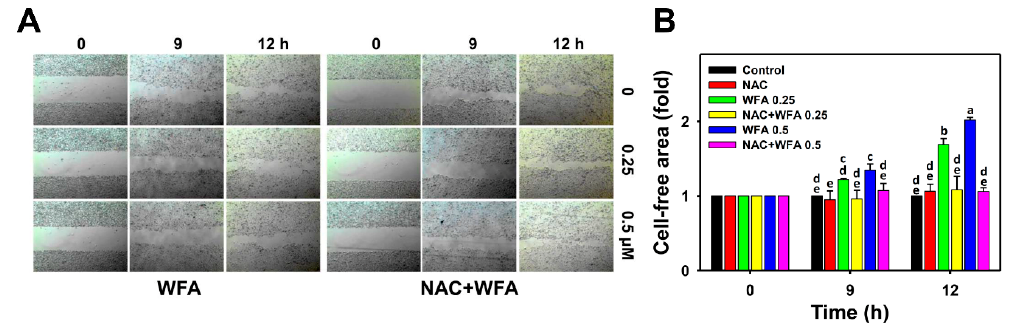
Figure 3. Two-dimensional anti-migration effects of low concentrations of WFA in oral cancer cells. ( A ) Two-dimensional migration (wound healing) images of Ca9-22 cells after NAC and/or WFA treatments. Cells were pretreated with or without NAC (2 mM, 1 h) and post-treated with different concentrations of WFA for 0, 9 and 12 h. ( B ) Statistics of 2D migration change in Figure 3A. For multiple comparison, treatments without the same labels (a–e) indicate the significant difference. p < 0.05~0.0001. Data, mean ± SD ( n = 3).